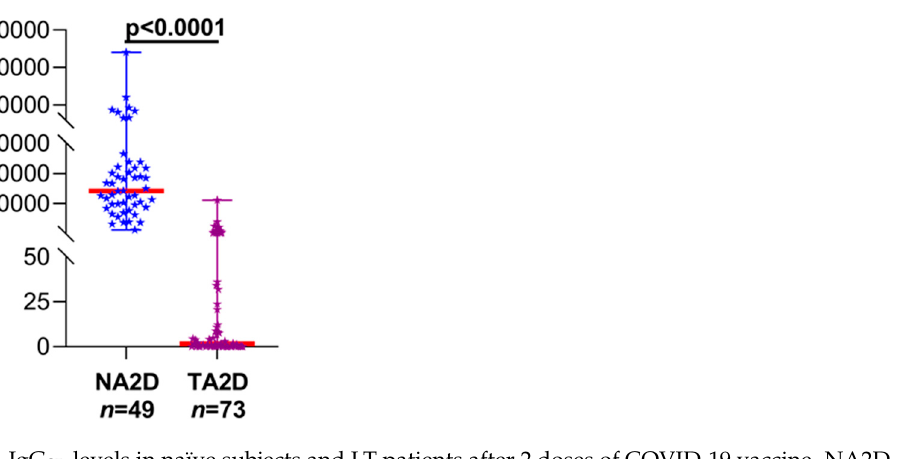
Figure 2. IgG SP levels in naïve subjects and LT patients after 2 doses of COVID-19 vaccine. NA2D, naïve subjects (non-transplanted and not had previous SARS-CoV-2 infection) after 2 doses of vaccine; TA2D, LT patients after 2 doses of vaccine; thick red line, median value.